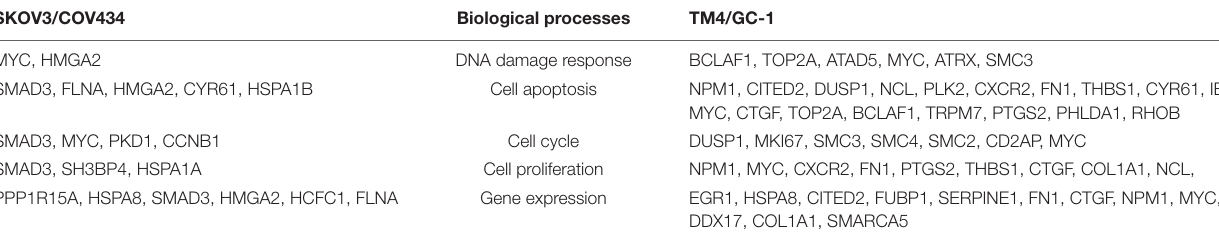
TABLE 6 | Different gene clusters involved in similar biological